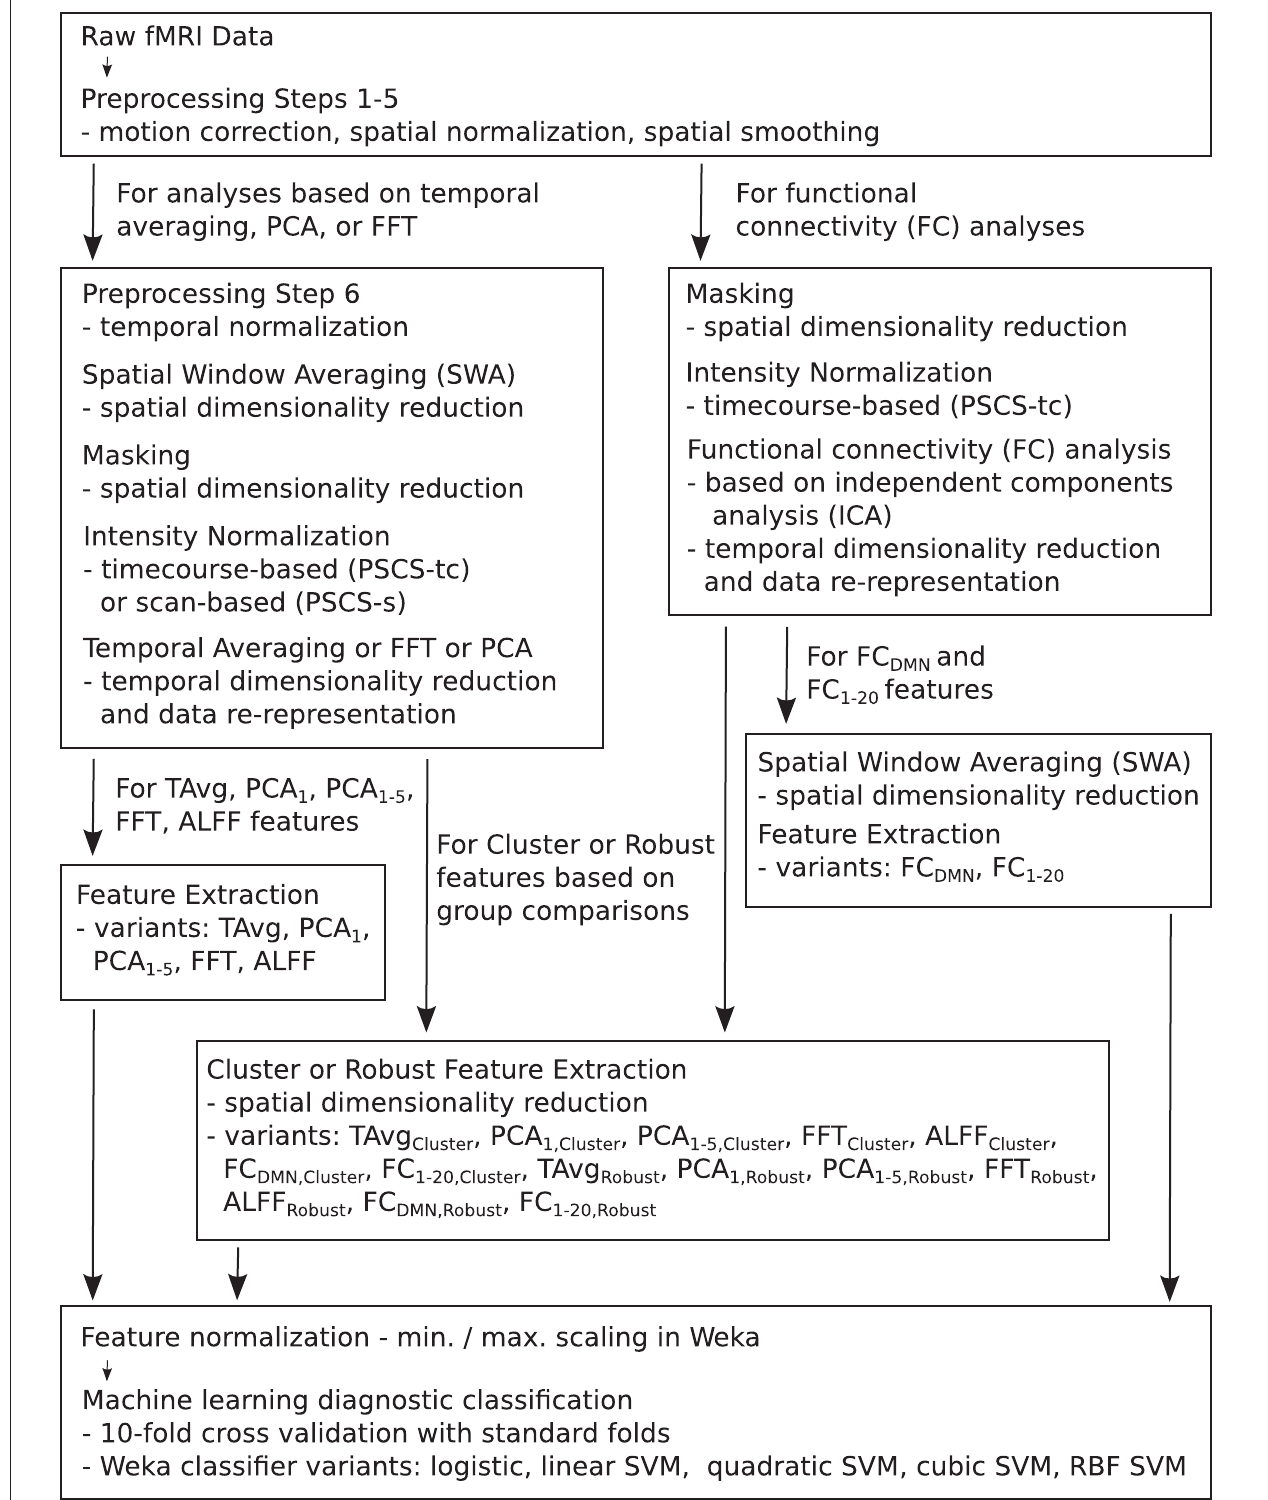
FIGURE 1 | Flow chart summarizing fMRI data preprocessing, normalization, dimensionality reduction, feature extraction, and testing in diagnosis tasks.